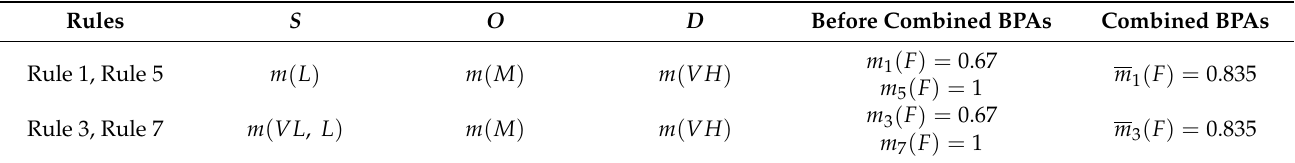
Table 6. Combined ER rules for S = 2, O = 5, D = 10 and S = 2, O = 5, D =